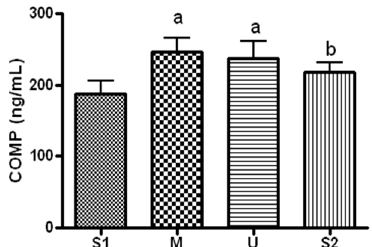
Figure 3. Serum COMP concentration in different locations. Values are mean ± S.D. Significance ( p < 0.05) is denoted by a: relative to S1 and b: relative to M. S1: Before start in Seoul, M: Moscow U: